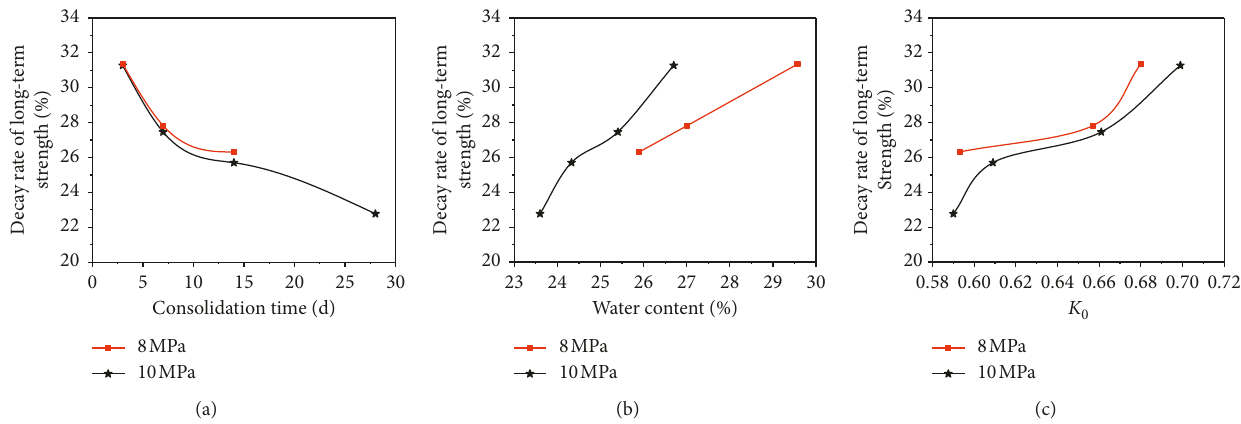
Figure 9: Variations in the strength decay rate of the frozen clay: (a) strength decay rate vs. t decay rate vs. K 0